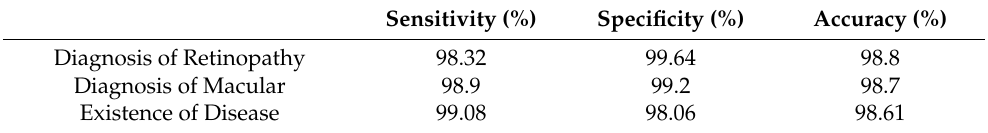
Table 2. Results from the diagnosis of convolution neural network disease on the MESSSIDOR